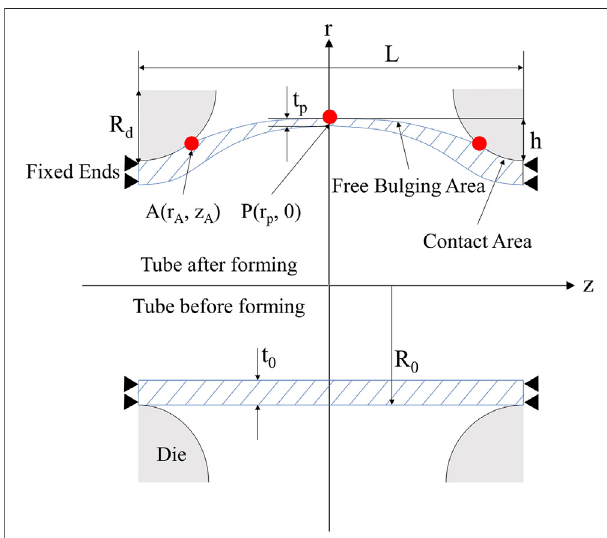
FIGURE 2 | Geometry of the die-related